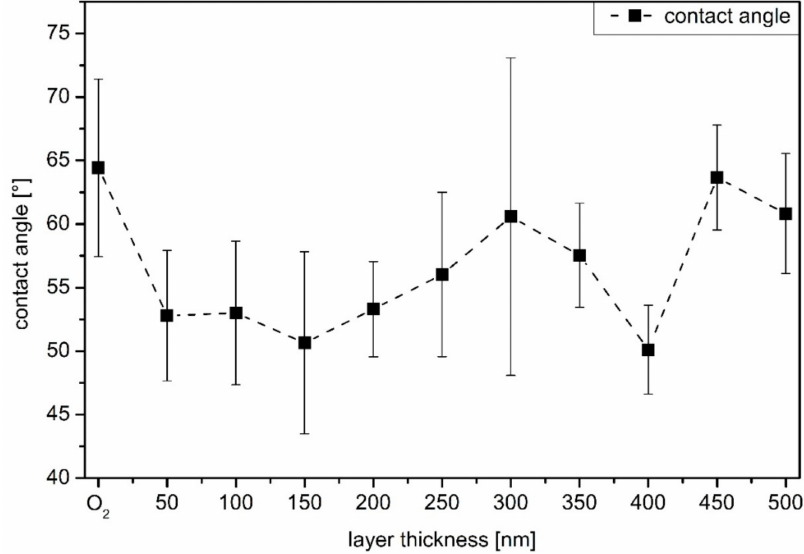
Figure 2. Contact angle results for the O 2 plasma cleaned and a-C:H coatings on PBAT previously treated by O 2 plasma with increasing thickness (the dashed line only indicates a trend of the